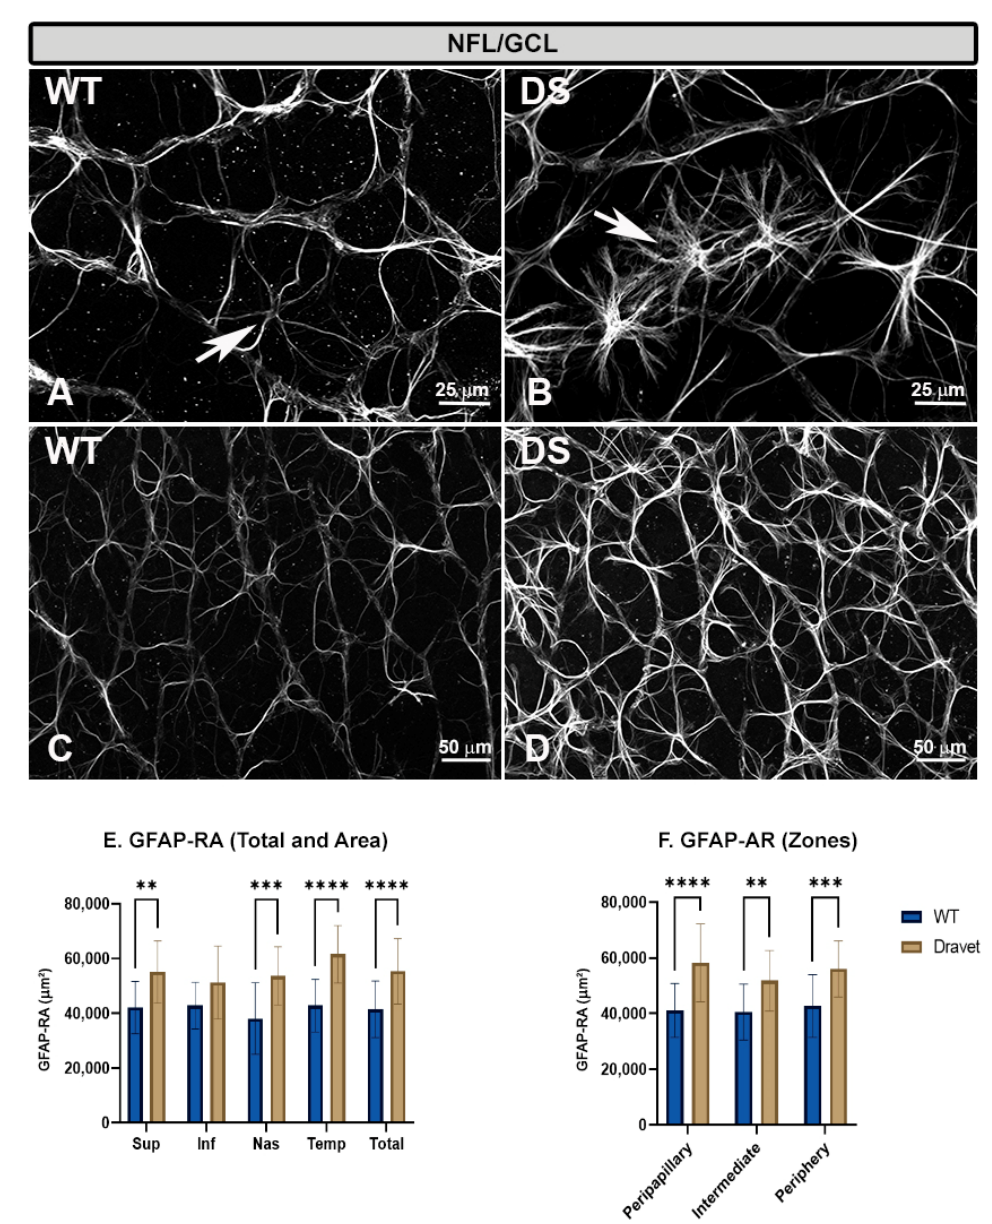
Figure 4. Astrocytes in the nerve fiber layer-ganglion cell layer (NFL-GCL). ( A – D ): retinal whole- mounts labeled with anti-GFAP at 20× magnification. ( A , C ) WT animals; ( B , D ) Dravet syndrome (DS) animals. Arrows indicate GFAP+ astrocytes. In the DS animals, the astrocytes were more robust and had thicker and much more numerous processes than in the WT animals, giving a denser appearance to the astroglial plexus. ( E , F ): Area of retina occupied by GFAP (GFAP-RA) by total retina and areas ( E ) and by zones ( F ). Two-way ANOVA. Data expressed as mean value (±SD). ** p < 0.01, *** p < 0.001, **** p < 0.0001. Number of retinas used in the experiment: WT animals n = 6, DS animals n = 6. Sup: superior; Inf: inferior; Nas: nasal; Temp: temporal.